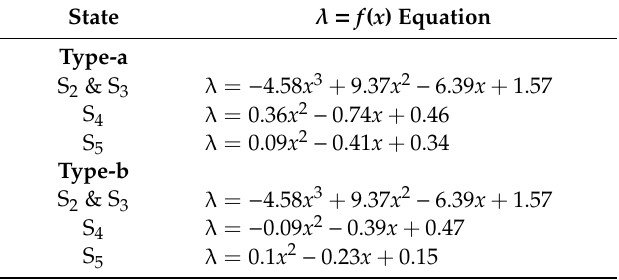
Table 2. Equations expressing λ as a function of the sag depth x for each of the FSM states and sag types.